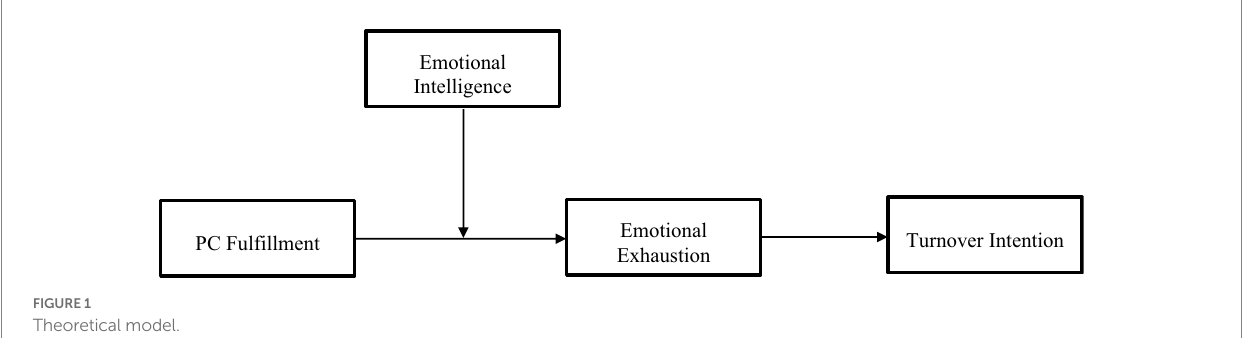
FIGURE 1 Theoretical